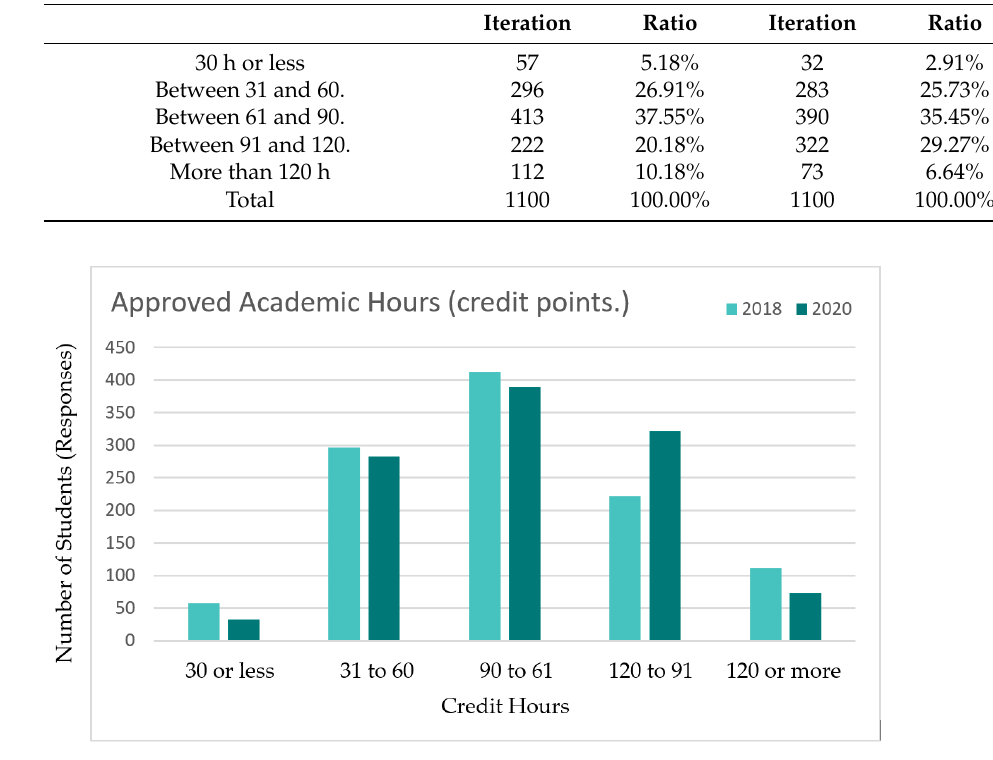
Figure 2. Distribution of student numbers by approved academic hours between 2018 and 2020 survey periods. Table 6. Distribution of student numbers by academic GPA in 2018 and 2020.